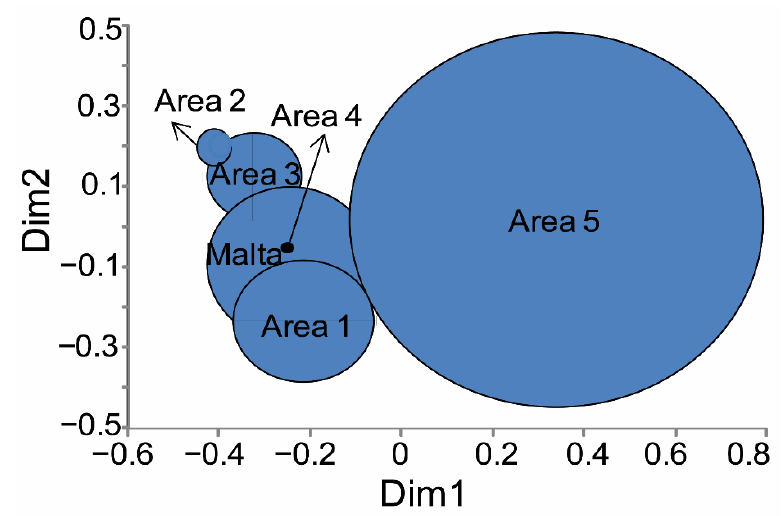
Figure 8. Amino acid random forest analysis. Plot of the mean ± sd of the first 2 dimensions’ scores obtained with the random forest performed on the amino acid composition in the different studied areas. Table 4. Confusion matrix resulting from random forest analysis on amino acid compositions. Bold numbers indicate correctly classified larvae.